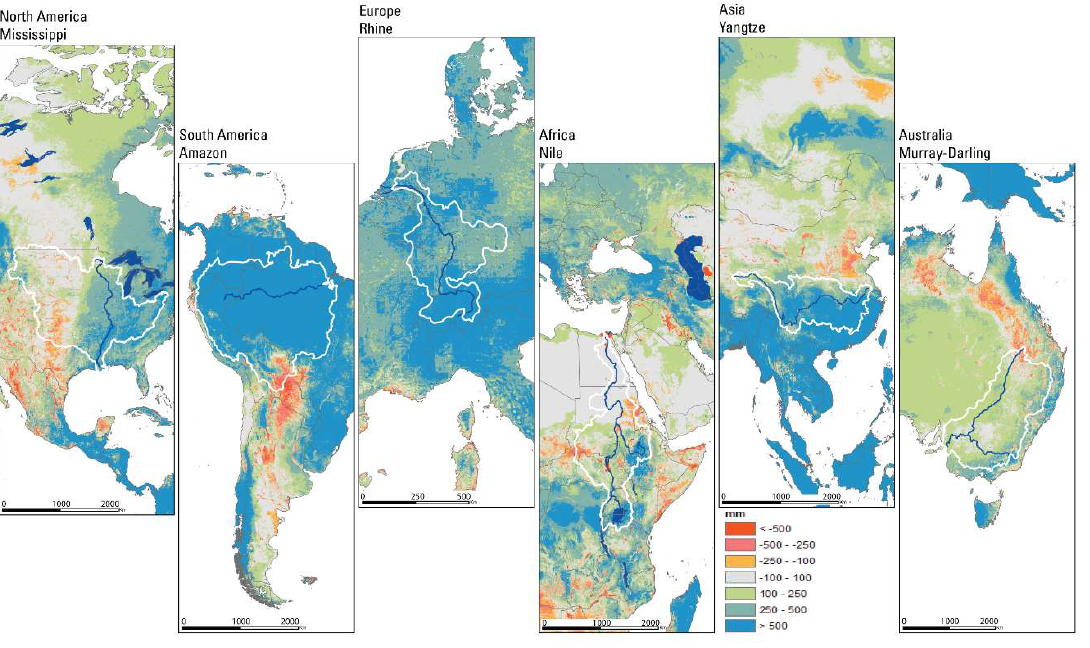
Table 5. Summary statistics for the six major river basins shown from left to right in Figure 5: basin name, area in km 2 , average annual ETa (mm) and precipitation (mm), and basin-wide ETcoeff (ETa/PPT) (%).